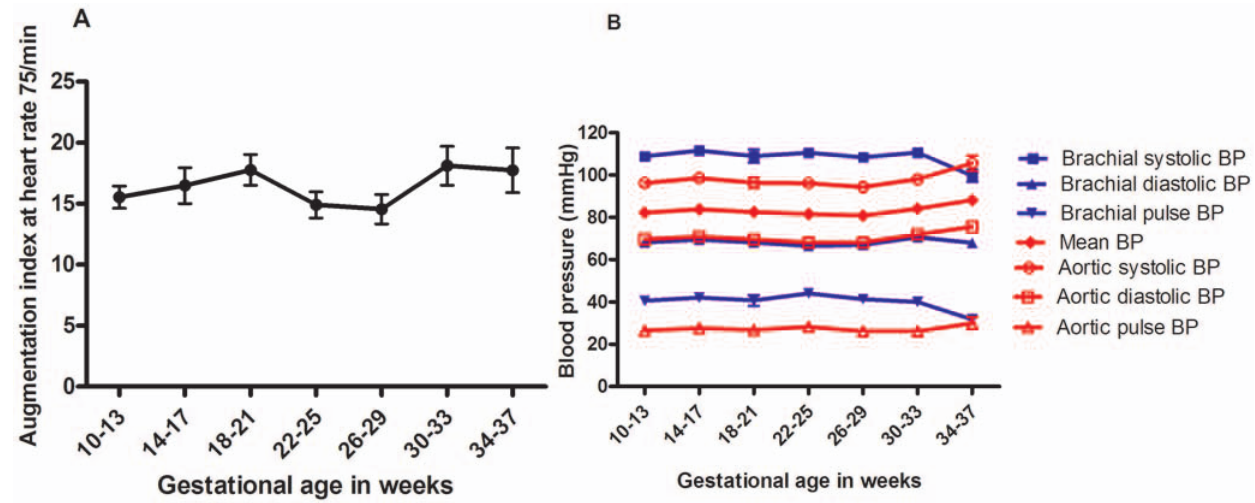
Figure 4. Monthly changes in augmentation index at heart rate of 75/min, central and peripheral blood pressure. Monthly [10 + 0 –13 + 6 weeks (n=145), 14 + 0 –17 + 6 weeks (n=56 ), 18 + 0 –21 + 6 weeks (n=55 ), 22 + 0 –25 + 6 weeks (n=104), 26 + 0 –29 + 6 weeks (n=86), 30 + 0 –33 + 6 weeks (n=57 ) and 34 + 0 –37 + 6 weeks of gestation (n=38)] changes throughout pregnancy in: (a) augmentation index at heart rate 75 beats per minute (AIx-75), and (b) brachial and aortic blood pressures. Values represent mean values and error bars represent standard errors. Only one measurement from each woman is included. BP=blood pressure.